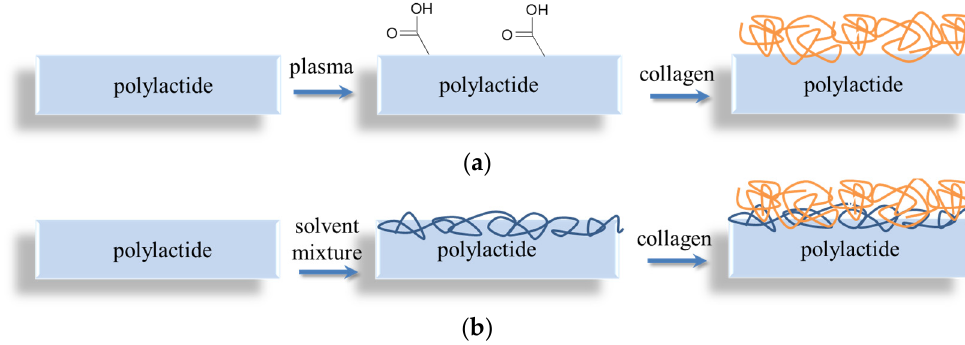
Figure 3. Schemes of collagen deposition onto PLA films via ( a ) plasma pre-treatment and ( b ) chemical entrapment methods.